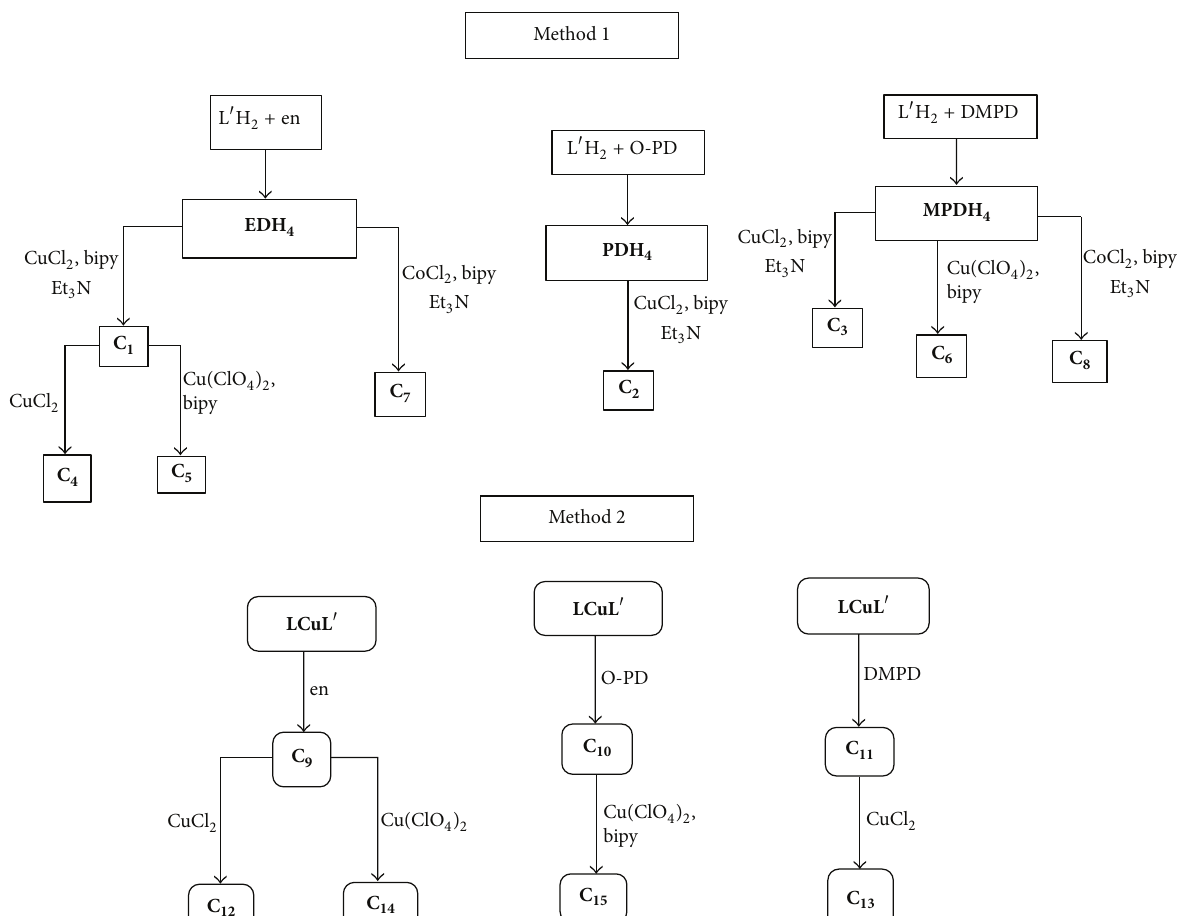
Scheme 1: The synthesis routes of the studied metal complexes by two different